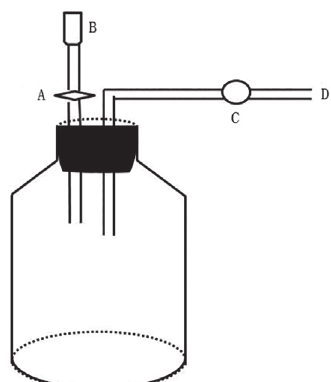
FIGURE 1 - Experimental devices of emptying rate and atomization determination A:Valve; B:Inhaler; C:Vacuum indicator; D:Vacuum